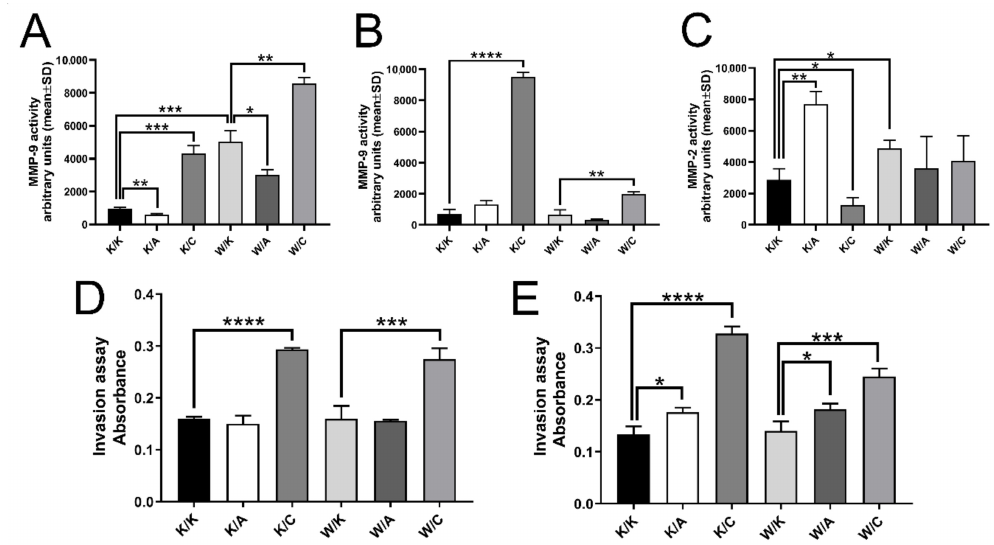
Figure 8. Disparities in the invasiveness potential and MMP-2/9 regulation. ( A ) MMP-9 activity in HT-1376. ( B ) MMP-9 activity in CAL-29. ( C ) MMP-2 activity in CAL-29. ( D ) Invasiveness of HT-1376. ( E ) Invasiveness of CAL-29. p < 0.05 (*), p < 0.01 (**), p < 0.001 (***), p < 0.0001